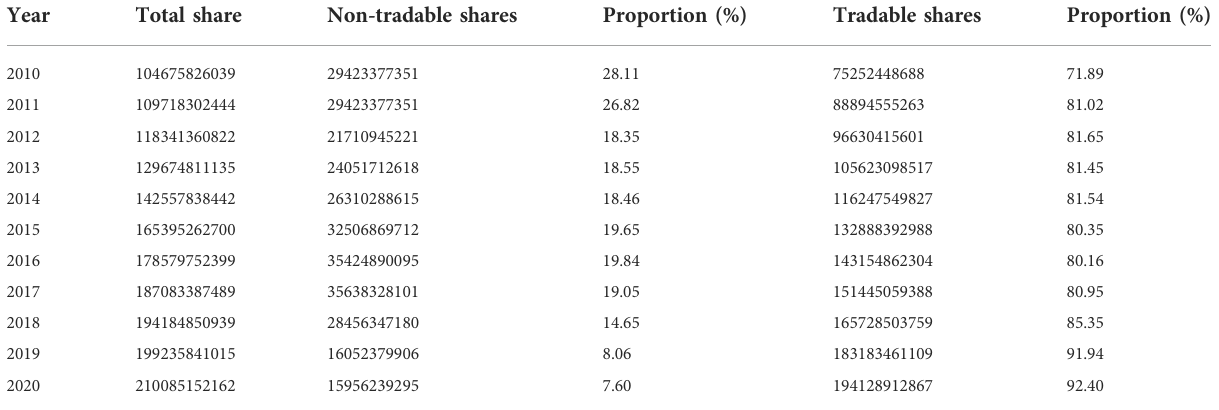
TABLE 2 Equity structure of l power